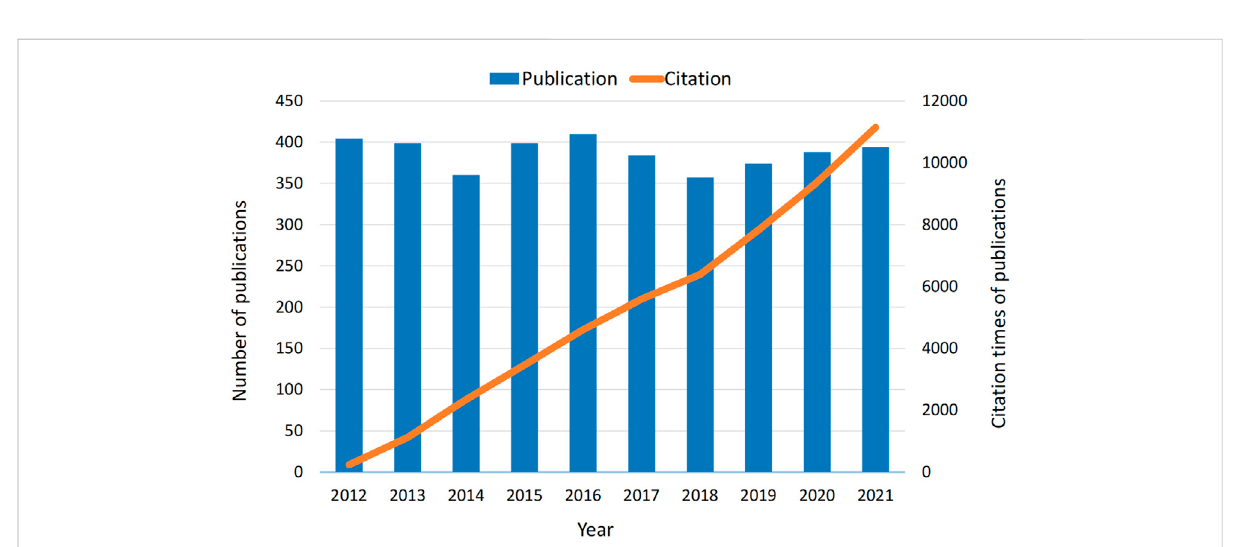
FIGURE 2 Annual output and citation times of publications with diazepam content from 2012 to